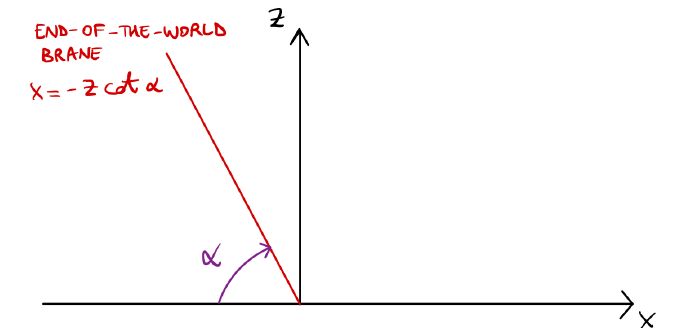
Figure 1 . Schematic set-up of the AdS/BCFT model. We represent a section at constant time and represent the end-of-the-world brane as the red hypersurface defined by x = − z cot α